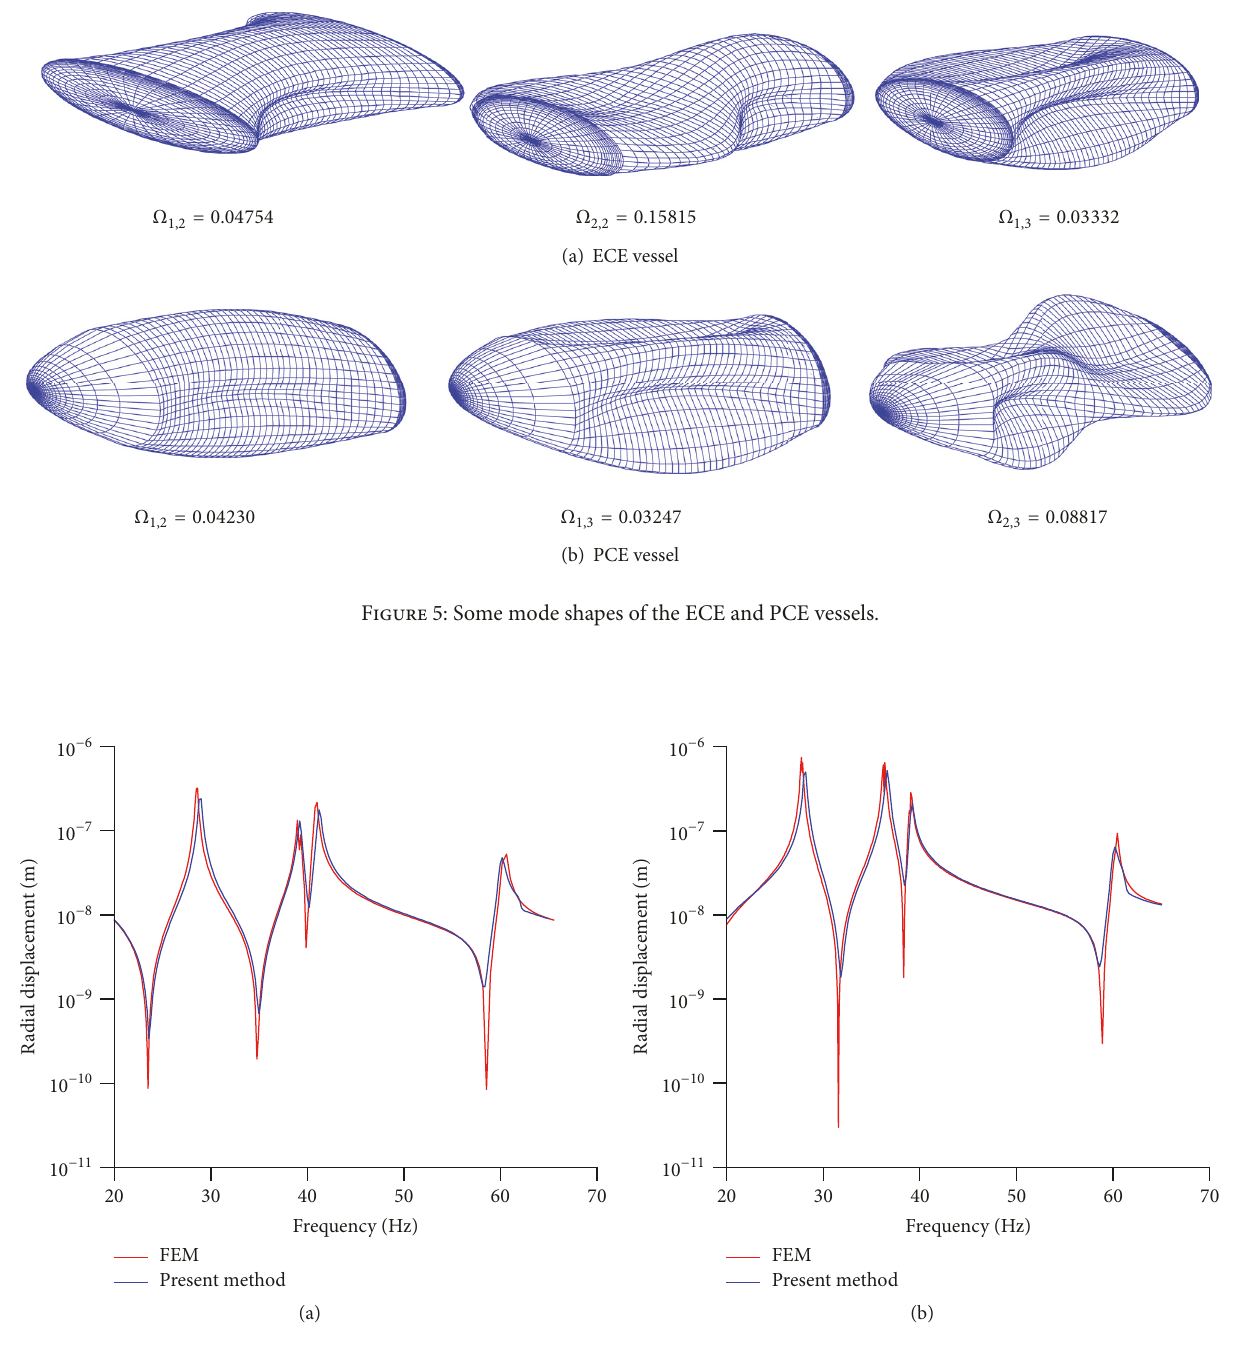
Figure 6: The radial displacements of point 𝐷 3 when the radial force 𝑓 𝑤 acts on point 𝐷 2 of the ECE vessel and the PCE vessel: (a) ECE vessel, (b) PCE